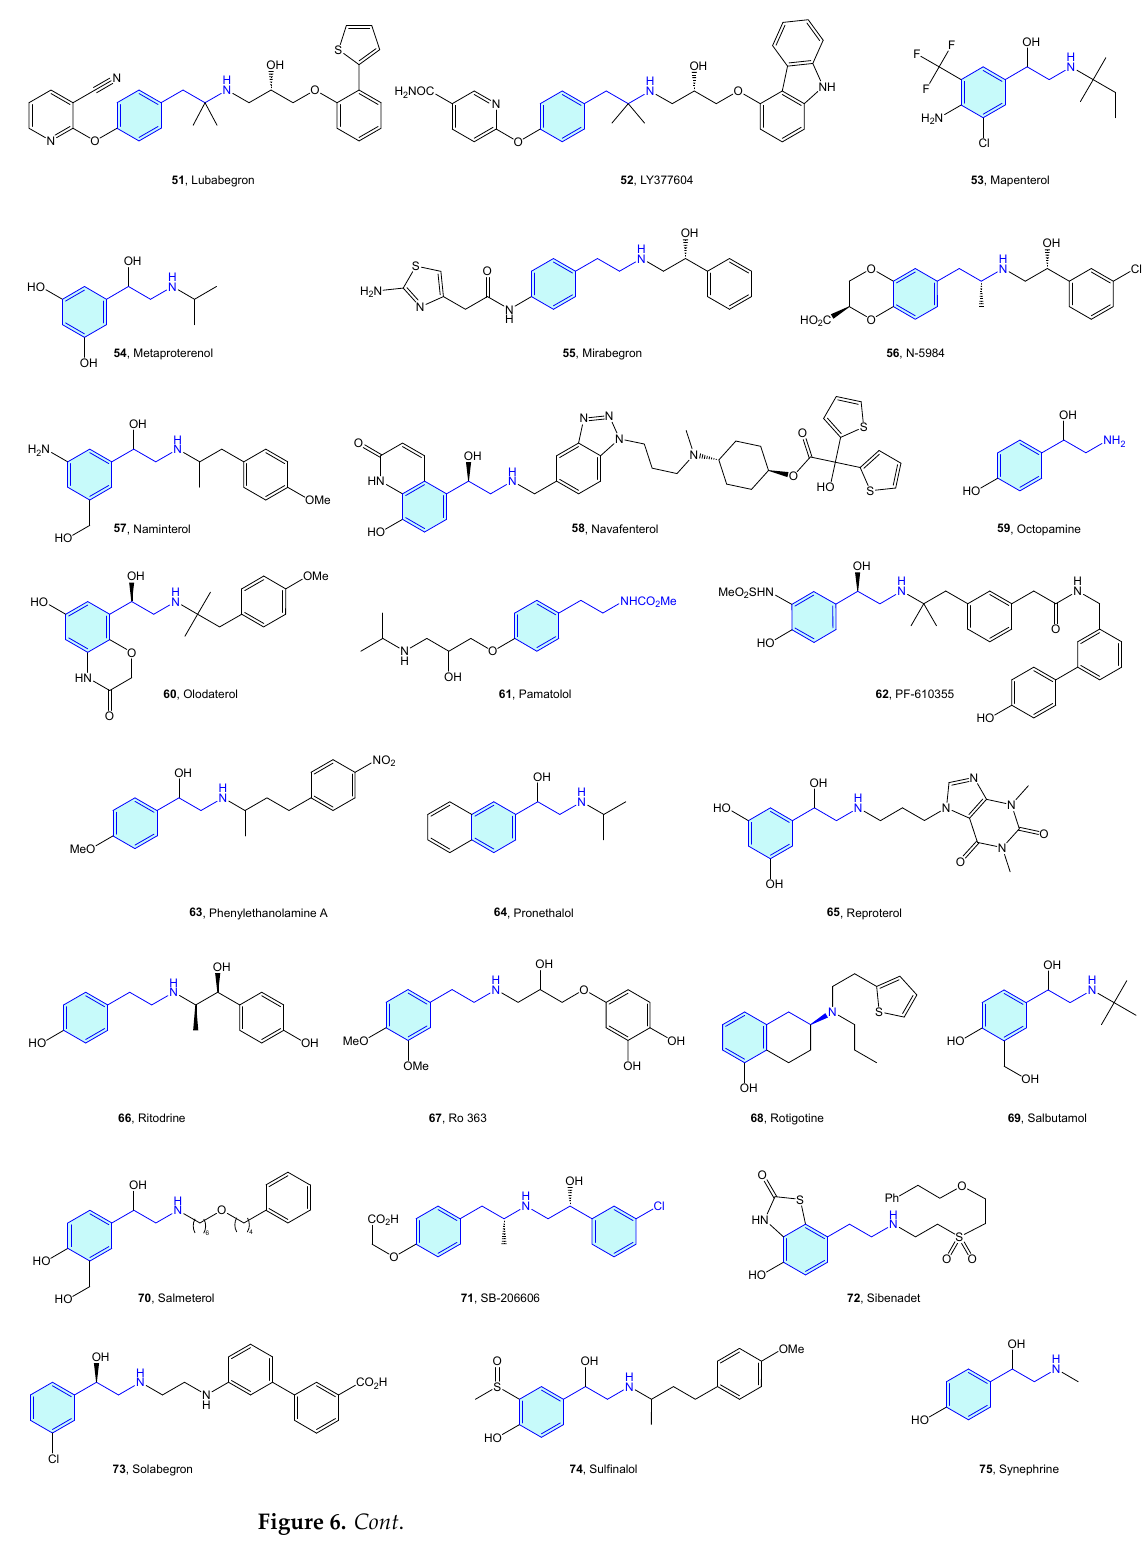
Figure 6. (cont.). 2-Phenylethyl-based β -adrenergic medicinal chemistry leads. Figure 6. Cont